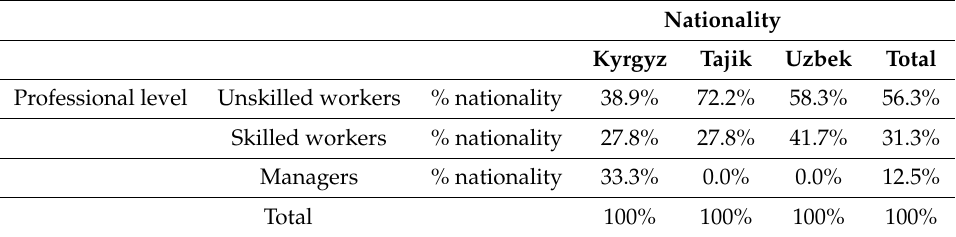
Table 1. Professional level of migrants.